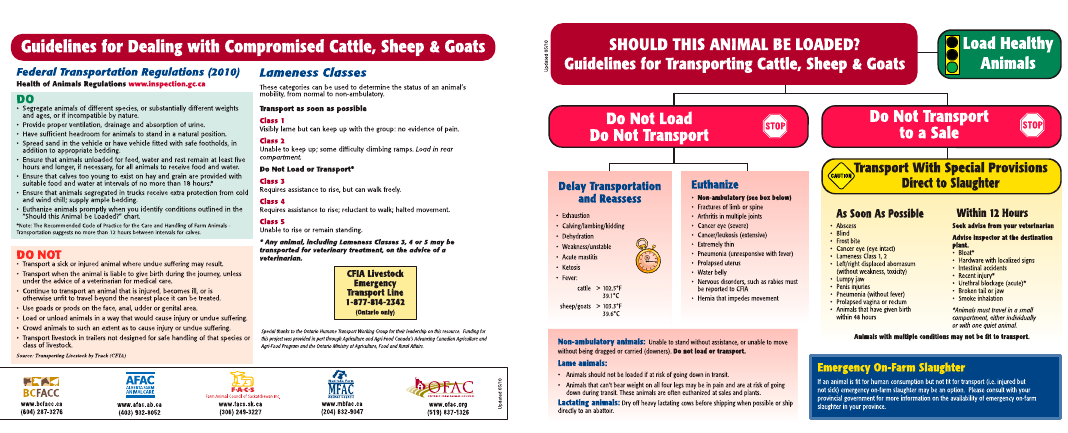
Figure 2. Example of guidelines available to assist producers and veterinarians with decisions surrounding animal transportation [62].